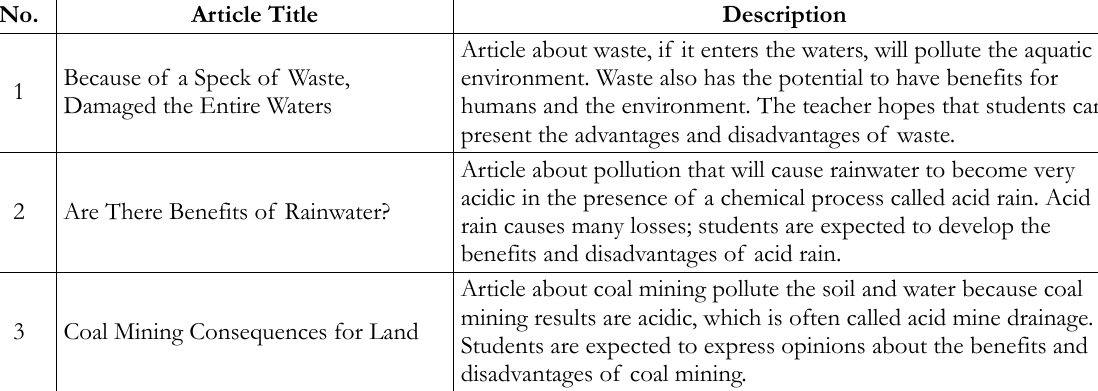
Table 2. Description of Social Issue Articles Related to the Environmental-Integrated Acids and Bases Concept The students then seek to understand and analyze the problem in the article. The use of social-environmental issues articles encouraged students to analyze problems quickly and relate these contextual issues to the chemistry concepts they are